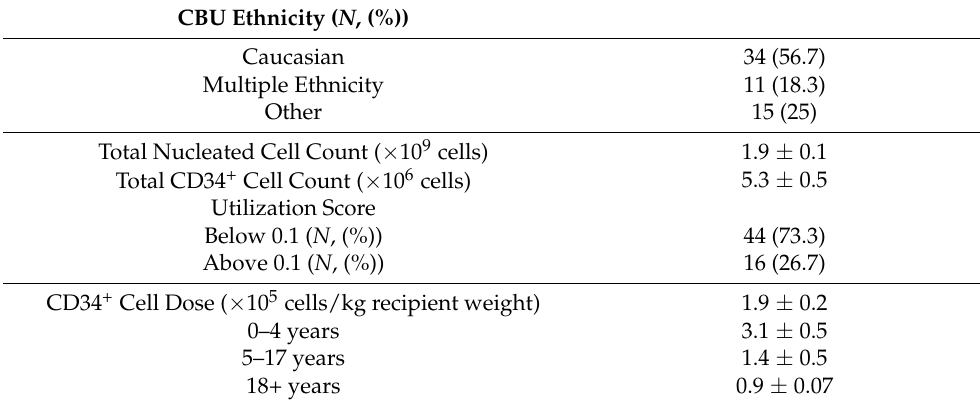
Table 3. Characteristics of distributed cord blood